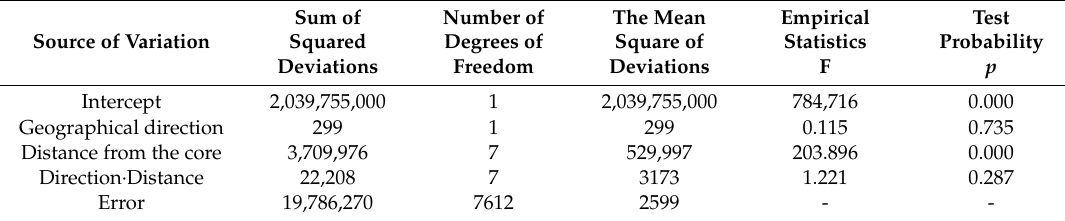
Figure 3. Density distribution of all logs of silver birch wood on the cross-section. Table 6. Two-factor analysis of variance (at the significance level p = 0.05) for the distribution of average densities across the entire birch log.